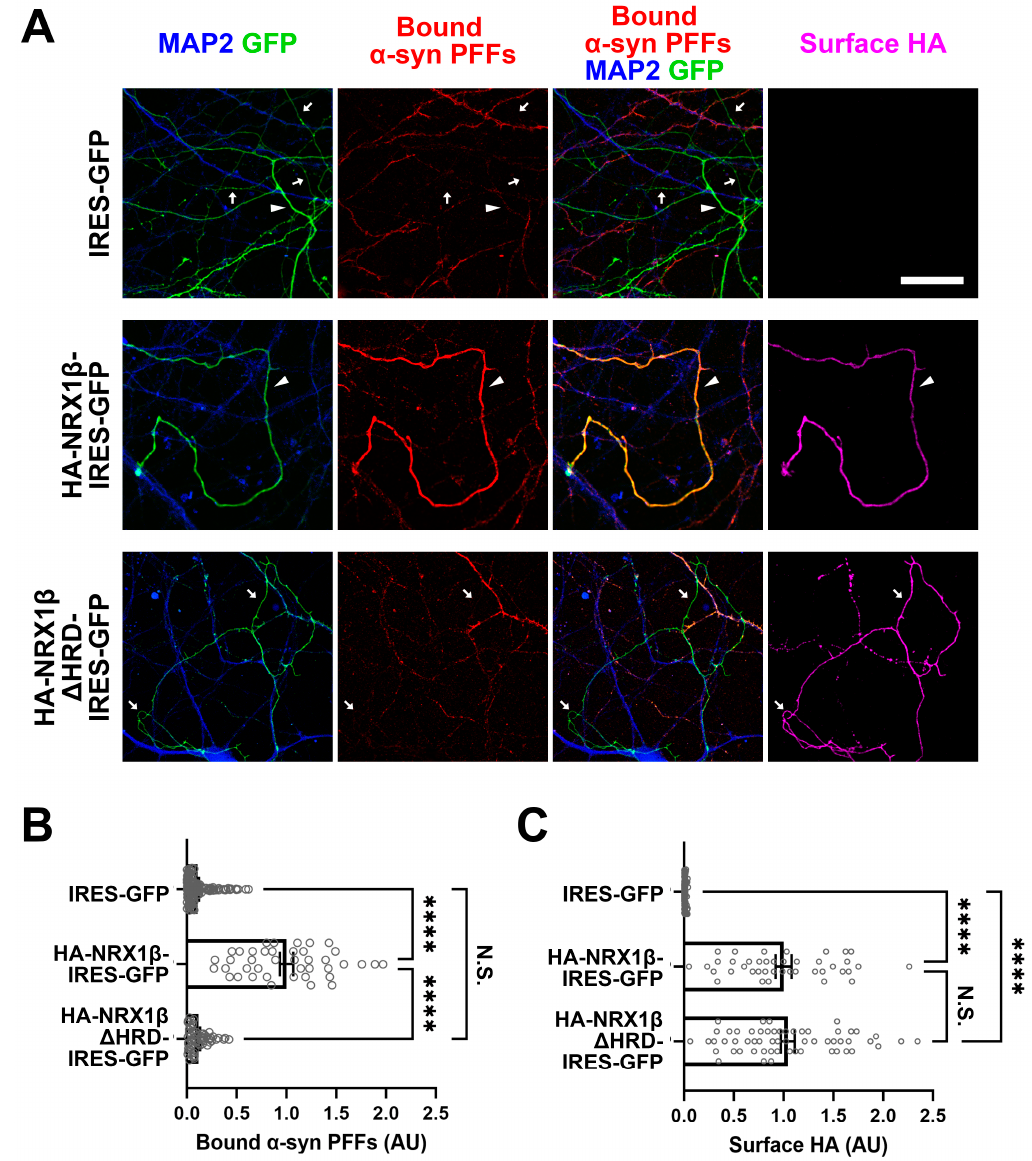
Figure 6. Axonal expression of NRX1 β enhances the binding of α -syn PFFs to the axon surface in